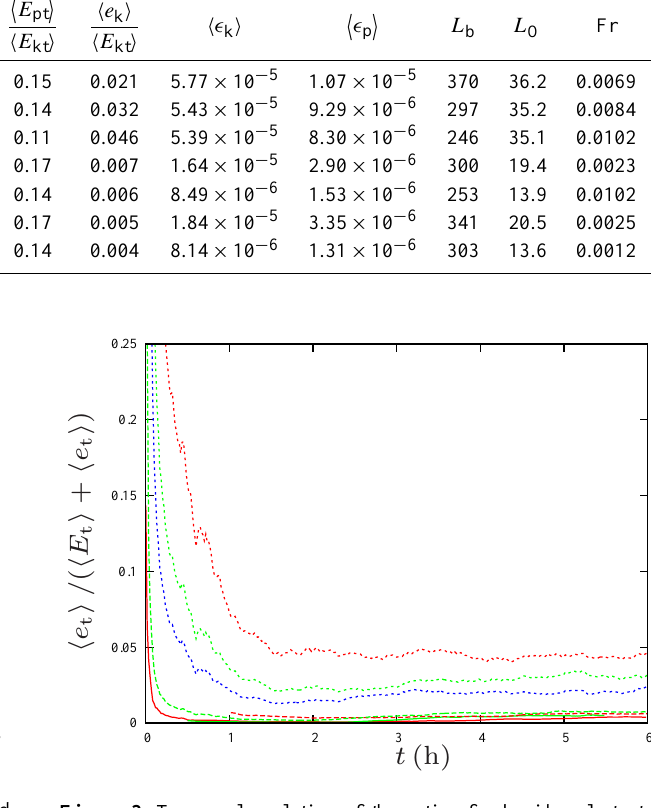
Figure 3. Temporal evolution of the ratio of subgrid-scale to to- tal turbulent kinetic energy R = h e k i /( h E kt i+h e k i ) for the weak forcing case (red lines), moderate forcing (green lines) case, and strong forcing case (blue line). Solid lines: 1 = 2m; dashed lines: 1 = 4m; dotted lines: 1 = 10m.